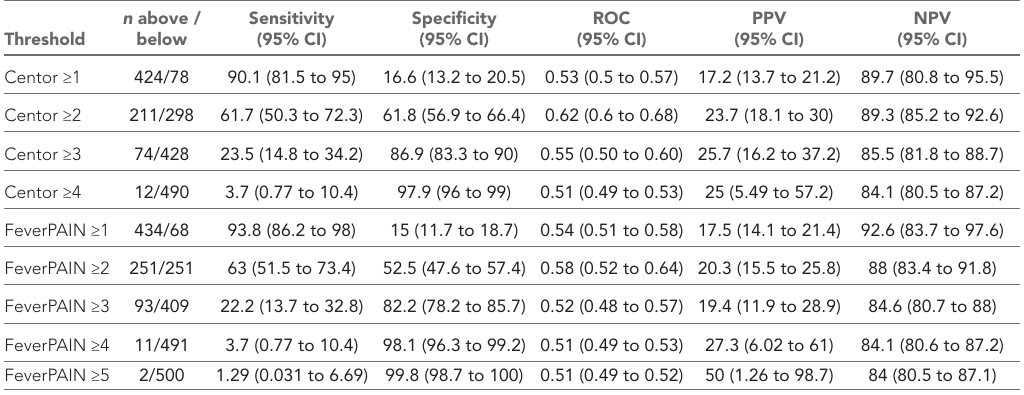
Table 2 Diagnostic accuracy at each threshold of clinical prediction